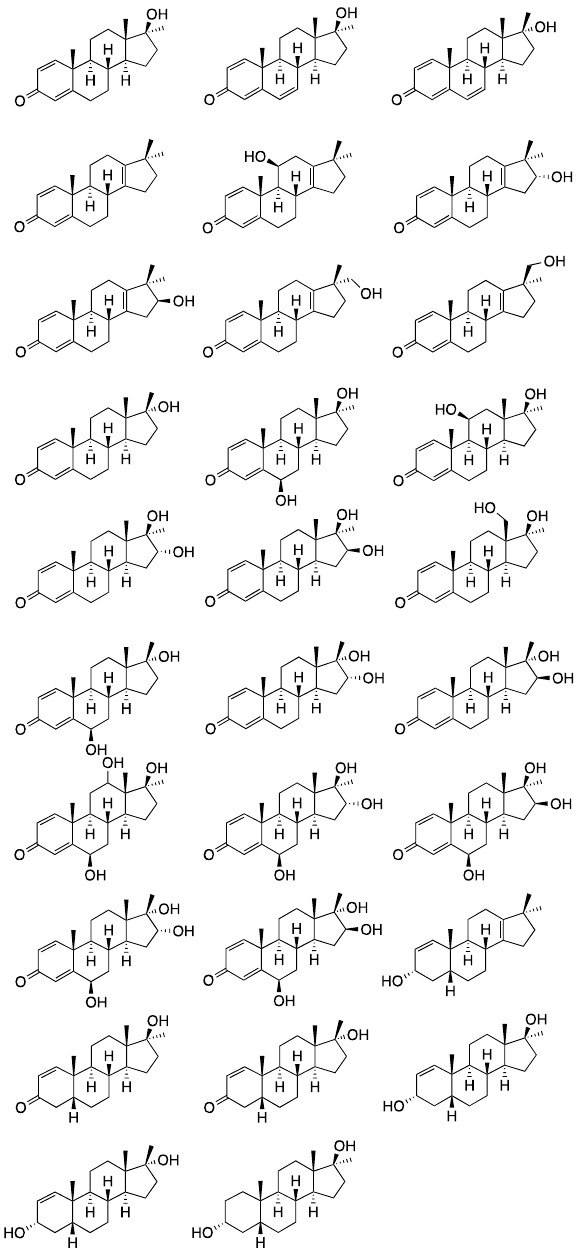
Figure 2. Chemical structures of phase I metabolites of metandienone reported in the literature.